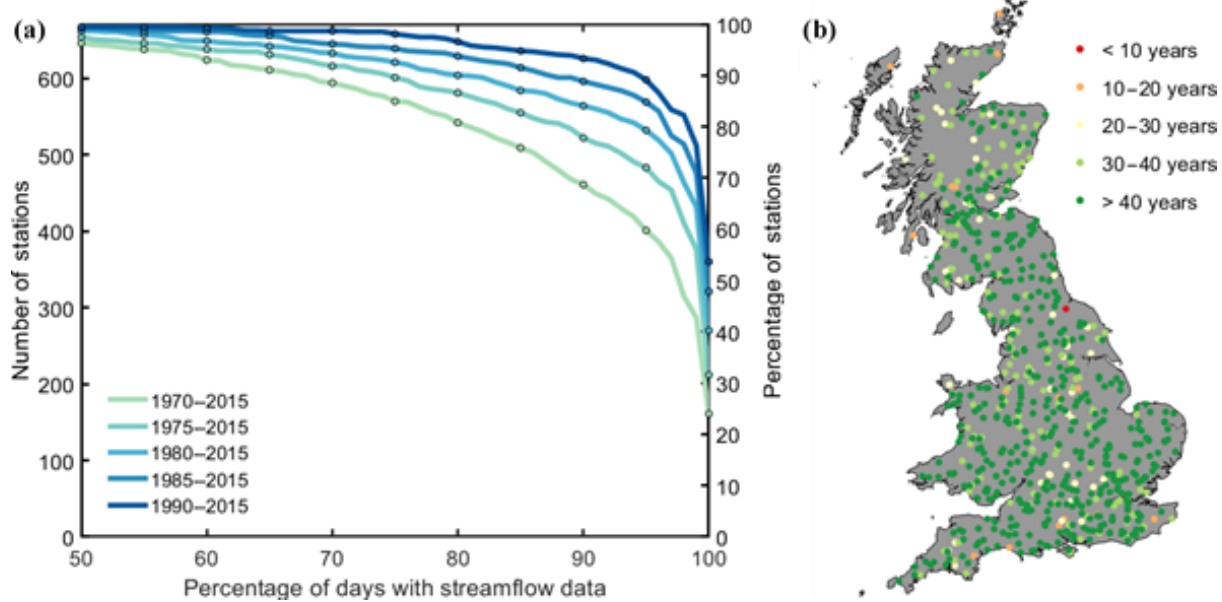
Figure 1. (a) Number of stations with percentage of available streamflow data for different periods. (b) Length of the flow time series for each